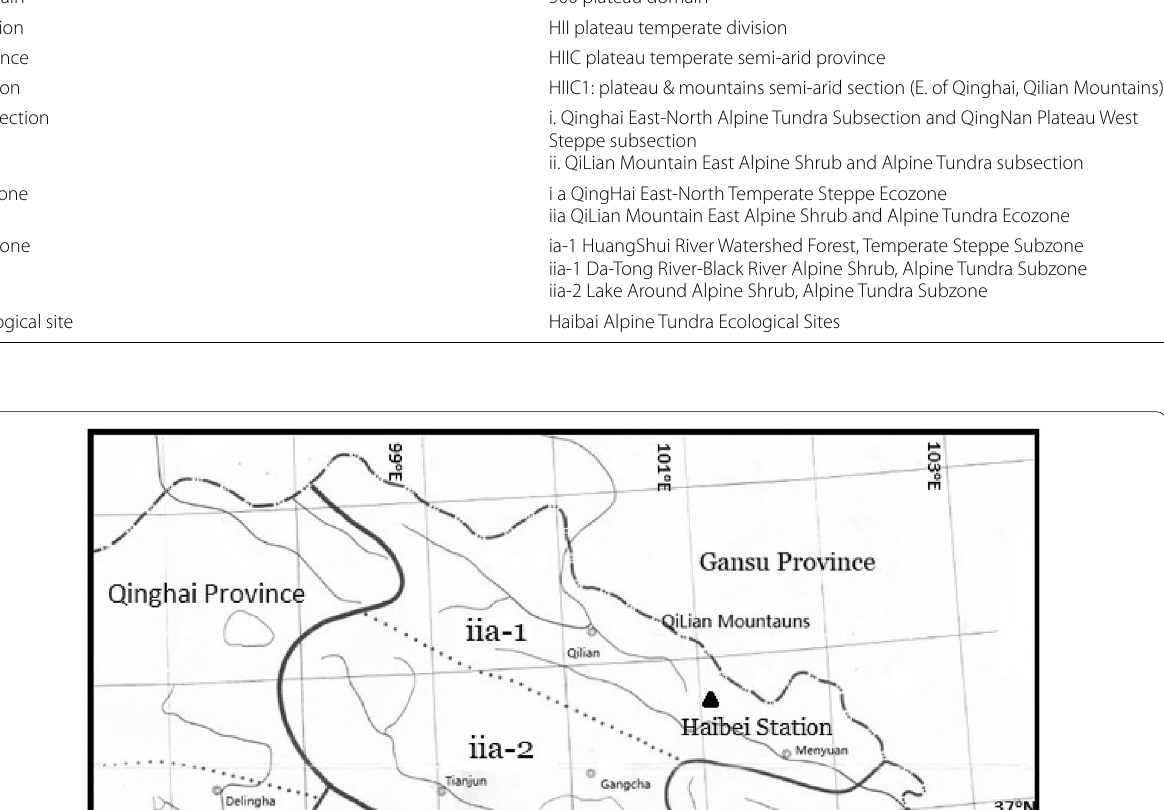
of 1° to 3° C. Since the study area was with the plain,